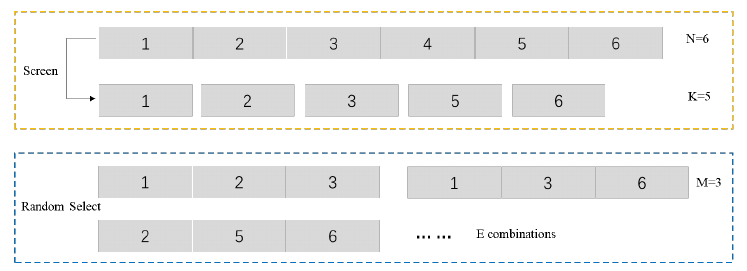
Figure 2. Explanatory diagrams of the four